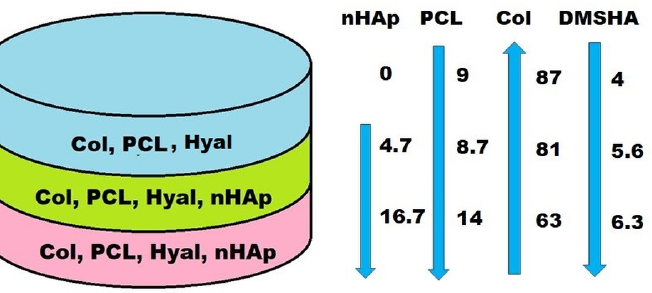
Figure 6. Schematic representation of the typical compositional (wt.%) variation in a trilayered construct (sample TL1).